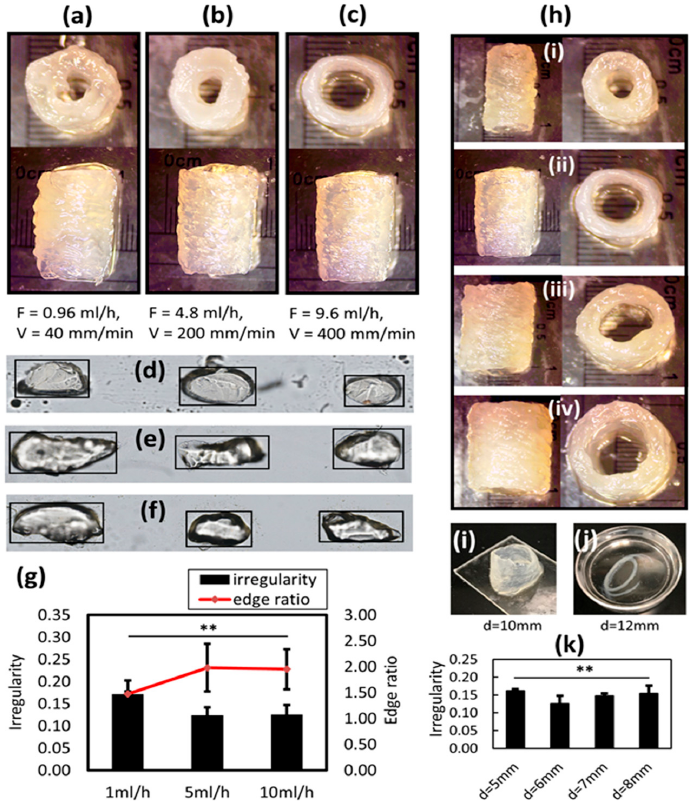
quality; ( a – c ) cross-sectional and side views of printed tubular structures at different flowrates and travel speeds; ( d – f ) cross sectional view with boundary boxes of filaments printed at the 3 different parameter sets; ( g ) combined plot of the edge irregularity and edge ratio (defined as length/width of the boundary boxes in ( d – f ); ( h ) the cross-sectional and side views of tubular structures printed at different diameters (5 mm–8 mm); ( i ) tubular structure is deformed with d = 10 mm; ( j ) tubular structure is disconnected between layers with d = 12 mm; ( k ) irregularity plot of the printed structures in ( g ).